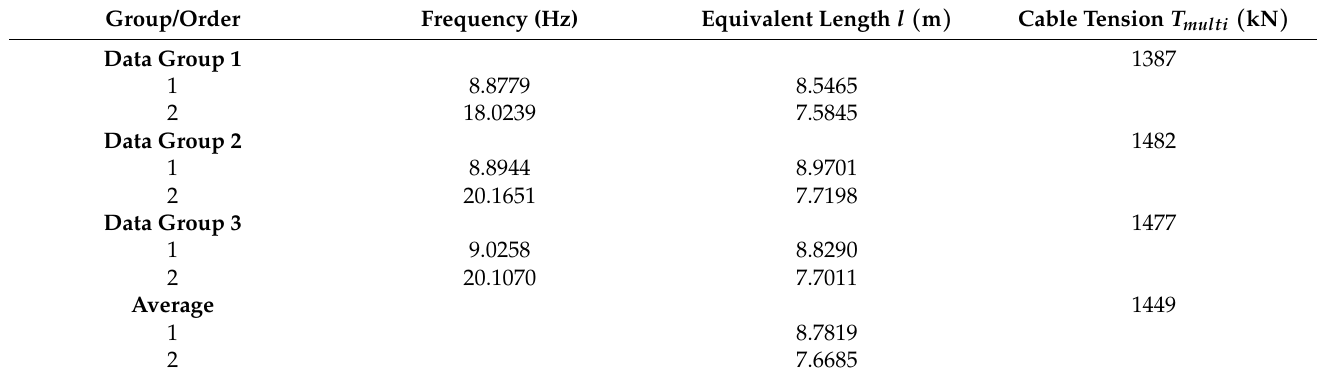
Table 3. Cable tension estimation results based on mode shape measurement (Data Group 1–3).